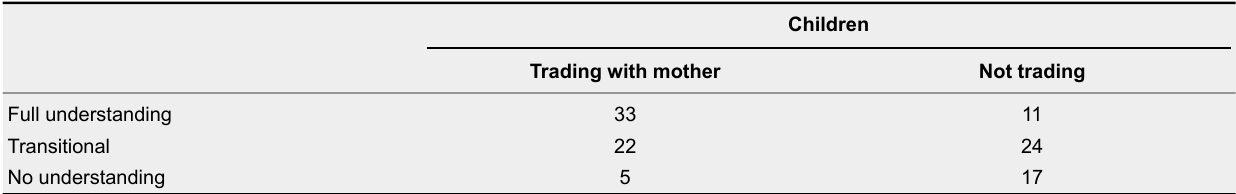
Understanding the Concept of ‘Profit’, According to Whether or not the Child Had Been Helping the Mother With Market